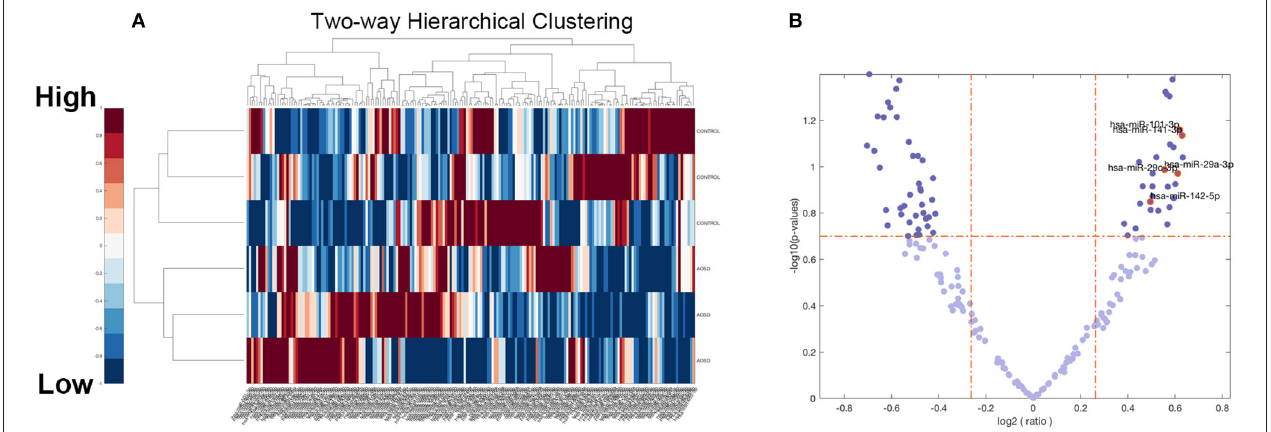
FIGURE 1 | Overview of miRNAs Sequencing Data from AOSD patients. (A) Volcano plot of the 482 miRNAs of 6 samples (3 AOSD and 3HCs). The abscissa represents log2 (fold change) of the miRNA expression while the ordinate represents the logarithmic transformation of the P -value gained by t -test. (B) Heat map with two-dimensional clustering of the imputed and normalized miRNA expression in the 6 samples. Missing data are intercepted before this procedure.